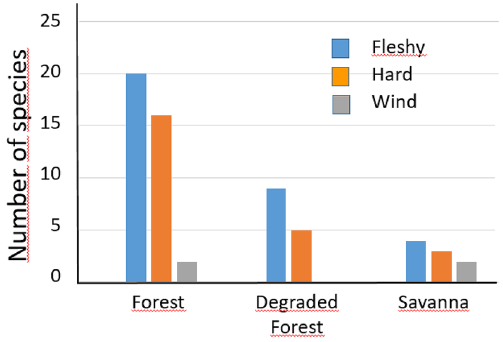
Figure 3. Representation of plant species with different types of fruit and seed dispersal in different vegetation